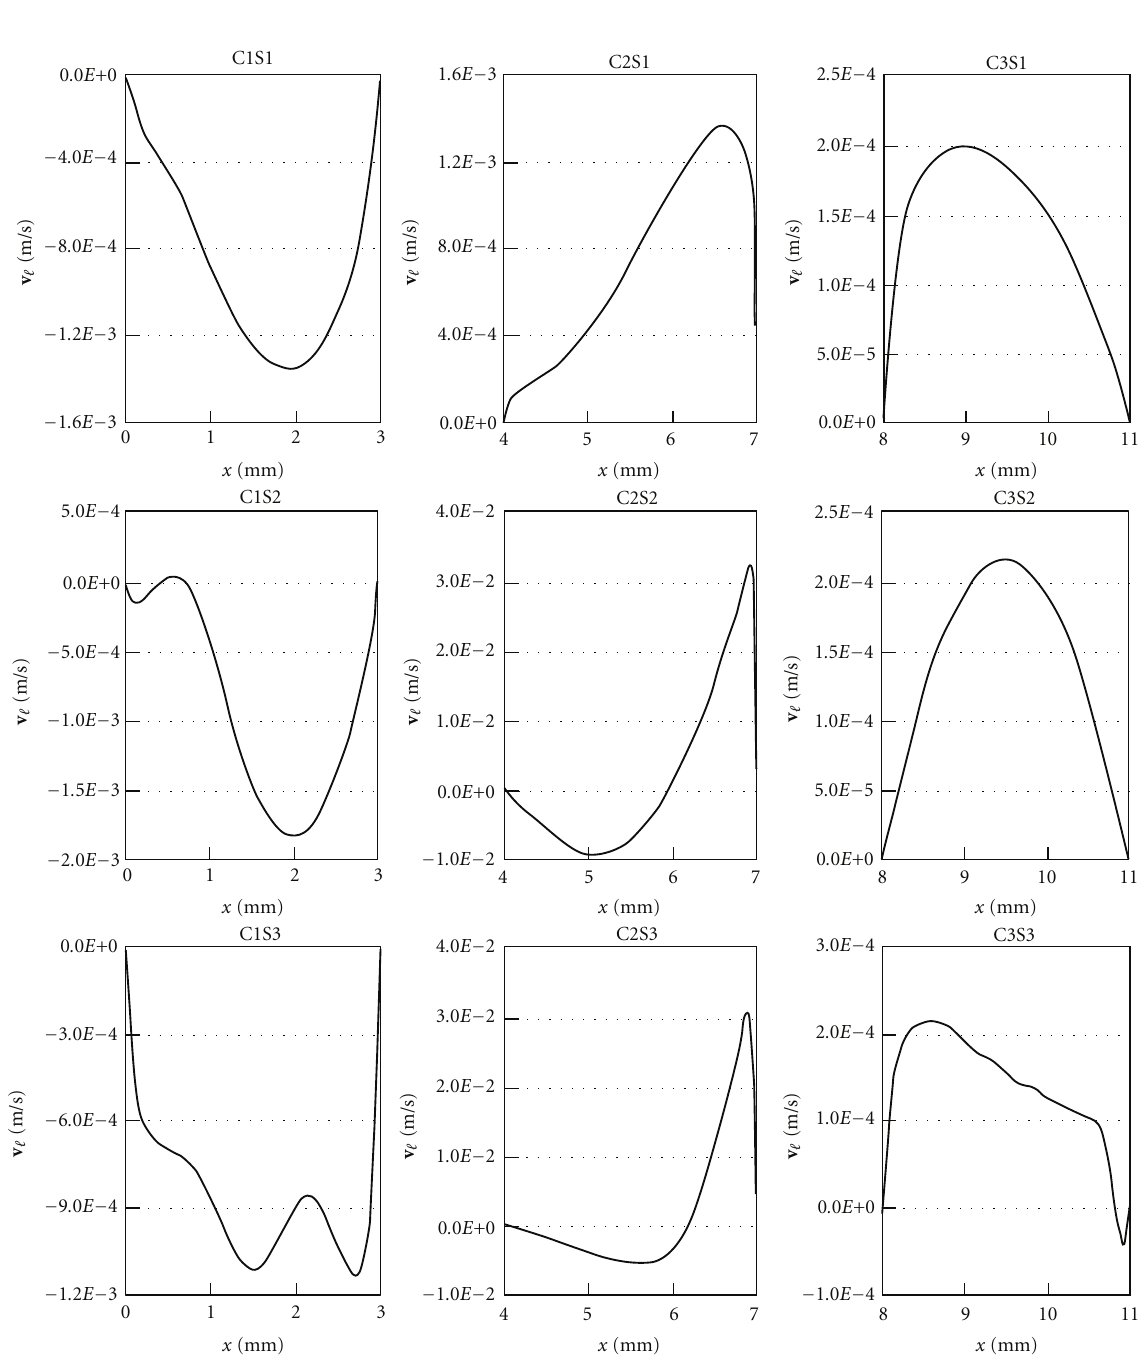
vortices and recirculation regions. There is a regular flow pattern of vortices with the same characteristic length as the channel width, whose direction of rotation alternates between clockwise and counterclockwise. It is important to note that these structures are not due to the e ff ect of turbulence since the flow is in the laminar regime having, due to the very small bubbles’ size and hydrogen density, characteristic particle Reynolds number of the order of 10 − 7 . These fluid structures increase dramatically the liquid